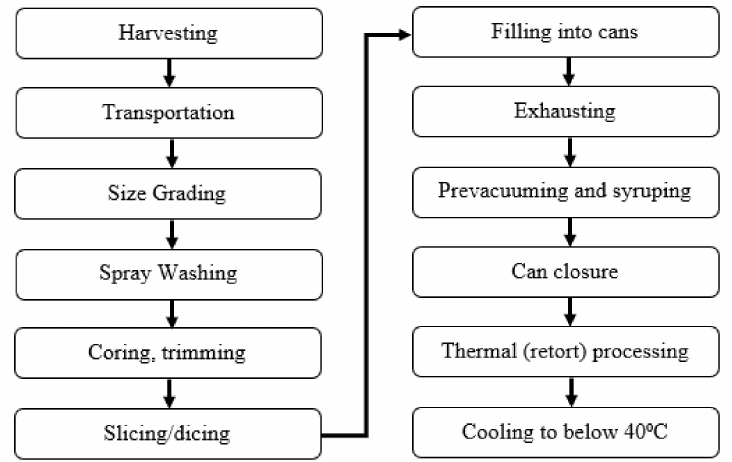
Figure 2. Pineapple canning process (adapted and modified from Downing [54] and Siow and Lee